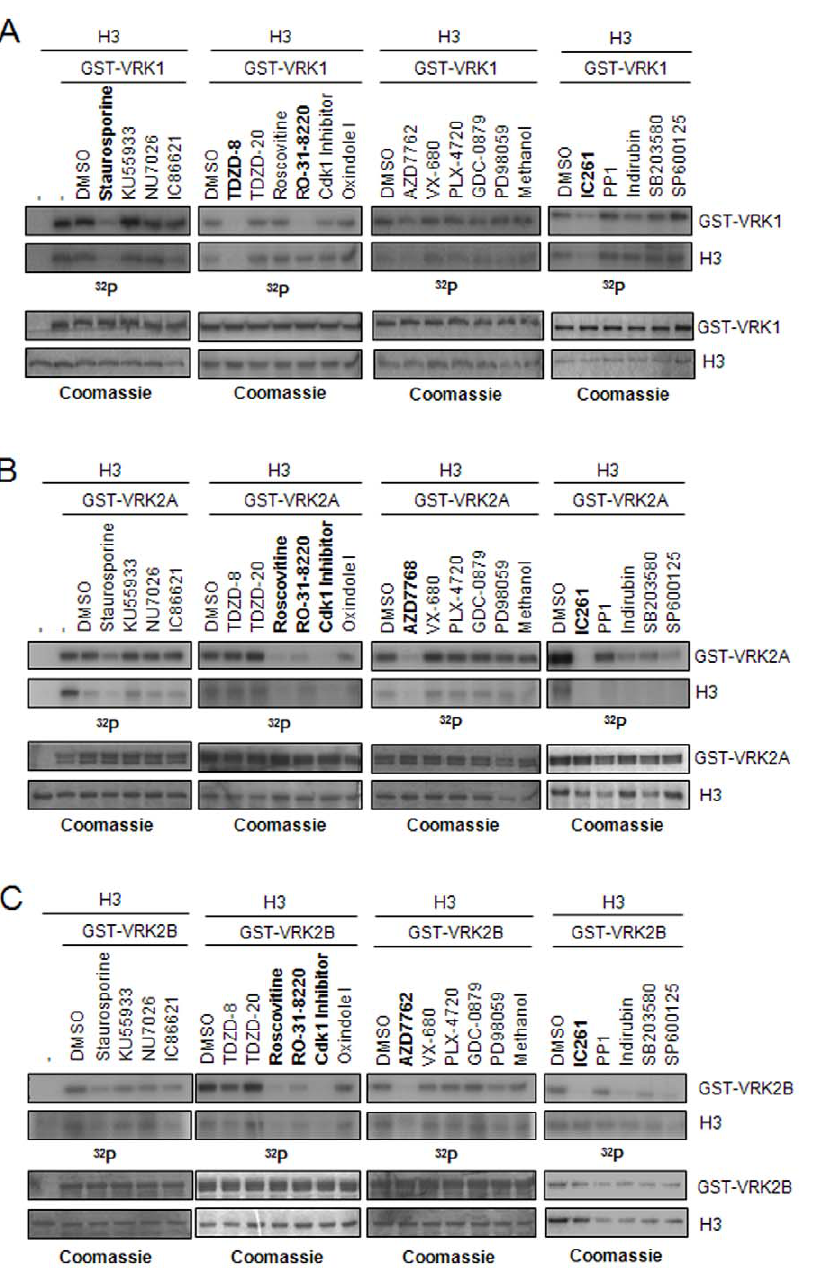
Figure 1. Effect of twenty different inhibitors on the kinase activity of human VRK1 (A), VRK2A (B) and VRK2B (C). The inhibition was assayed using both autophosphorylation (top), and phosphorylation of histone H3 (bottom), as targets in the kinase assay. All inhibitors were used at 100 m M. In bold are marked those inhibitors that appear to be somewhat more effective in the inhibition of each kinase. The top gels show the in vitro kinase assay with ATP (5 m M) and [ c - 32 P]-ATP (5 m Ci), incubated for 30 minutes at 30 u C. The bottom gels show the protein levels detected by Coomassie blue staining. The assays contain 2 m g of the indicated kinase and 1 m g of recombinant H3. TDZD-8 and TDZD-20 are non-competitive inhibitors. All the other compounds are competitive inhibitors.